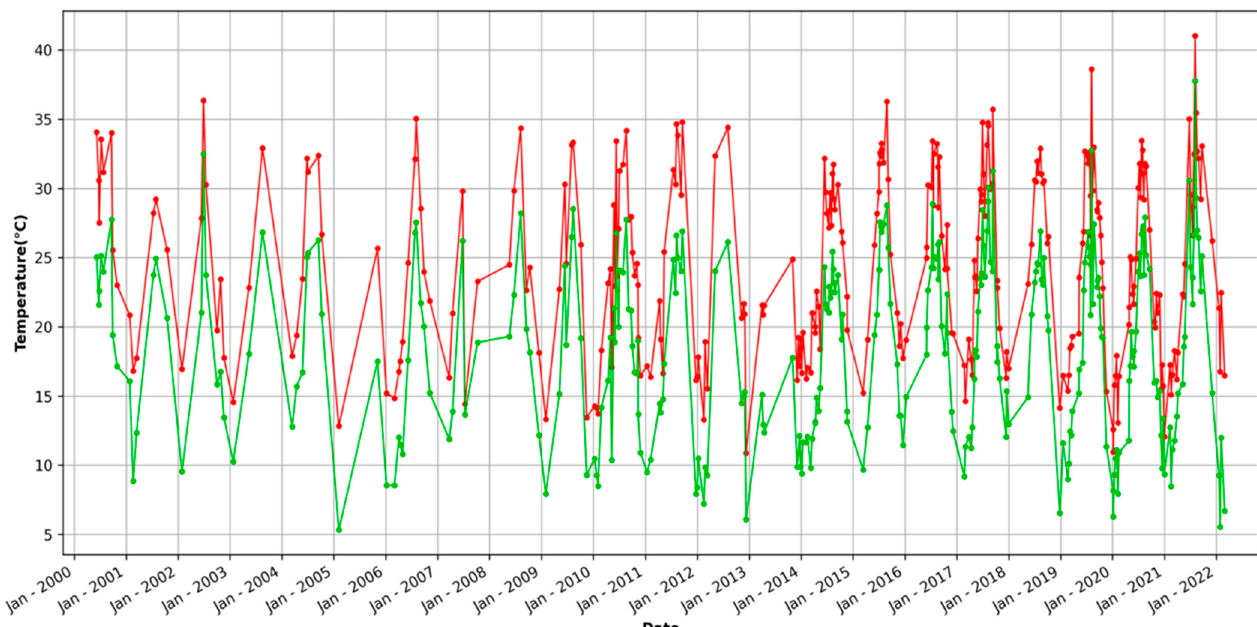
Figure 6. Cumulative temperature time series estimated by integrating ASTER and TIRS. In red the mean value of the four hottest pixels derived from PPI analysis, in green the temperature of the background pixel.